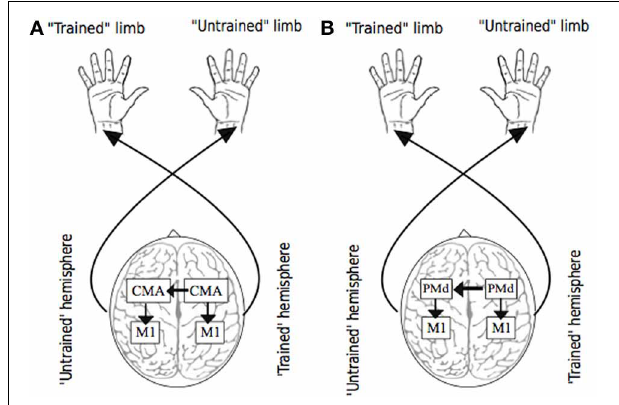
FIGURE 3 | Putative sources of transfer. Panel (A) illustrates the possibility that as a consequence of (transcallosal) interactions between cingulate motor areas (CMA) during unilateral training, bilateral adaptations occur in circuits projecting from CMA, including those to targets within M1. Panel (B) illustrates the possibility that as a consequence of (transcallosal) interactions between dorsal premotor cortices (PMd) during unilateral training, bilateral adaptations occur in circuits projecting from PMd, including those to targets within